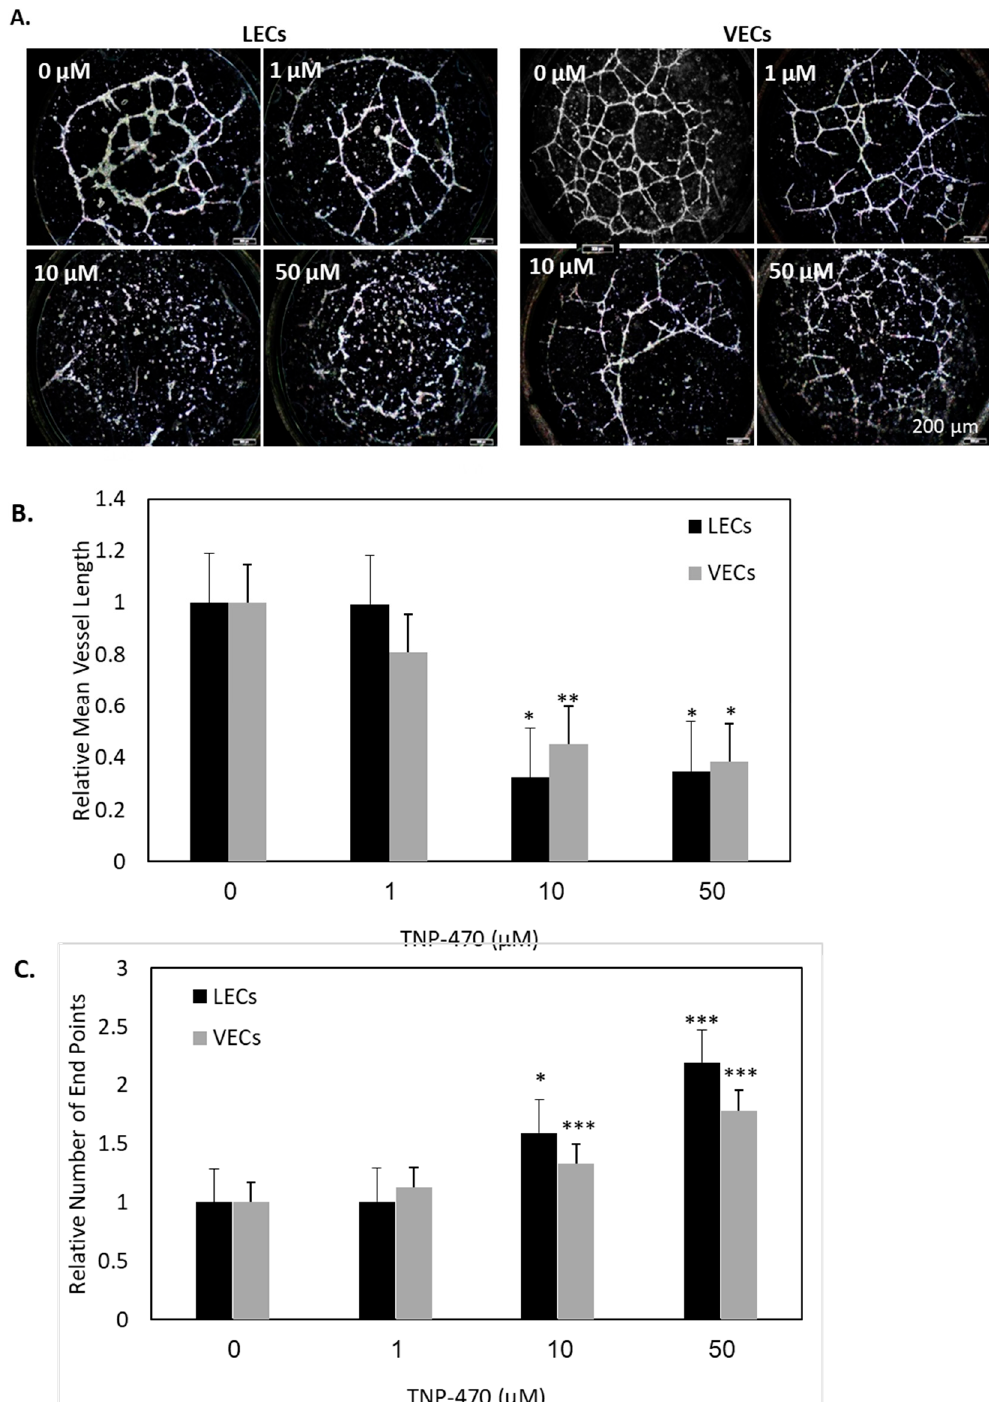
Figure 5. MetAp2 inhibition blocked tube formation in VECs and LECs. ( A ) MetAp2 inhibition impaired HUVECs’ and HMVEC-dLyAd cells’ ability to form tubes. HUVECs and HMVEC-dLyAd cells were seeded on Matrigel and incubated for 14 h under different concentration treatments of TNP-470 (0–50 µM). When no TNP-470 was present, extensive neovascularization was clearly visible and an organized capillary network was formed. When the dose of TNP-470 was elevated to 1–50 µm, the cells’ ability to migrate and reorganize into tubes was impaired. n = 8. ( B , C ) Metap2 inhibition resulting from exposure to TNP-470 caused a reduction in the relative vessel length and an increase in the relative number of end points in both cell lines, as quantified using the AngioTool image analysis software. n = 8. * p < 0.05, *** p < 0.001. The results are presented as mean ± SEM. Scale bar = 200 µ